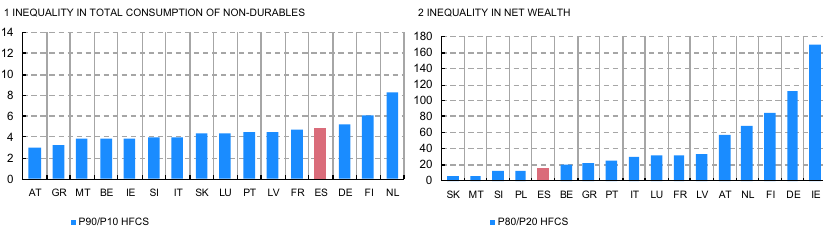
Fig. 6 International comparison of inequality indicators. Household consumption and wealth (2014). Sources : European Central Bank (European Household Finance and Consumption